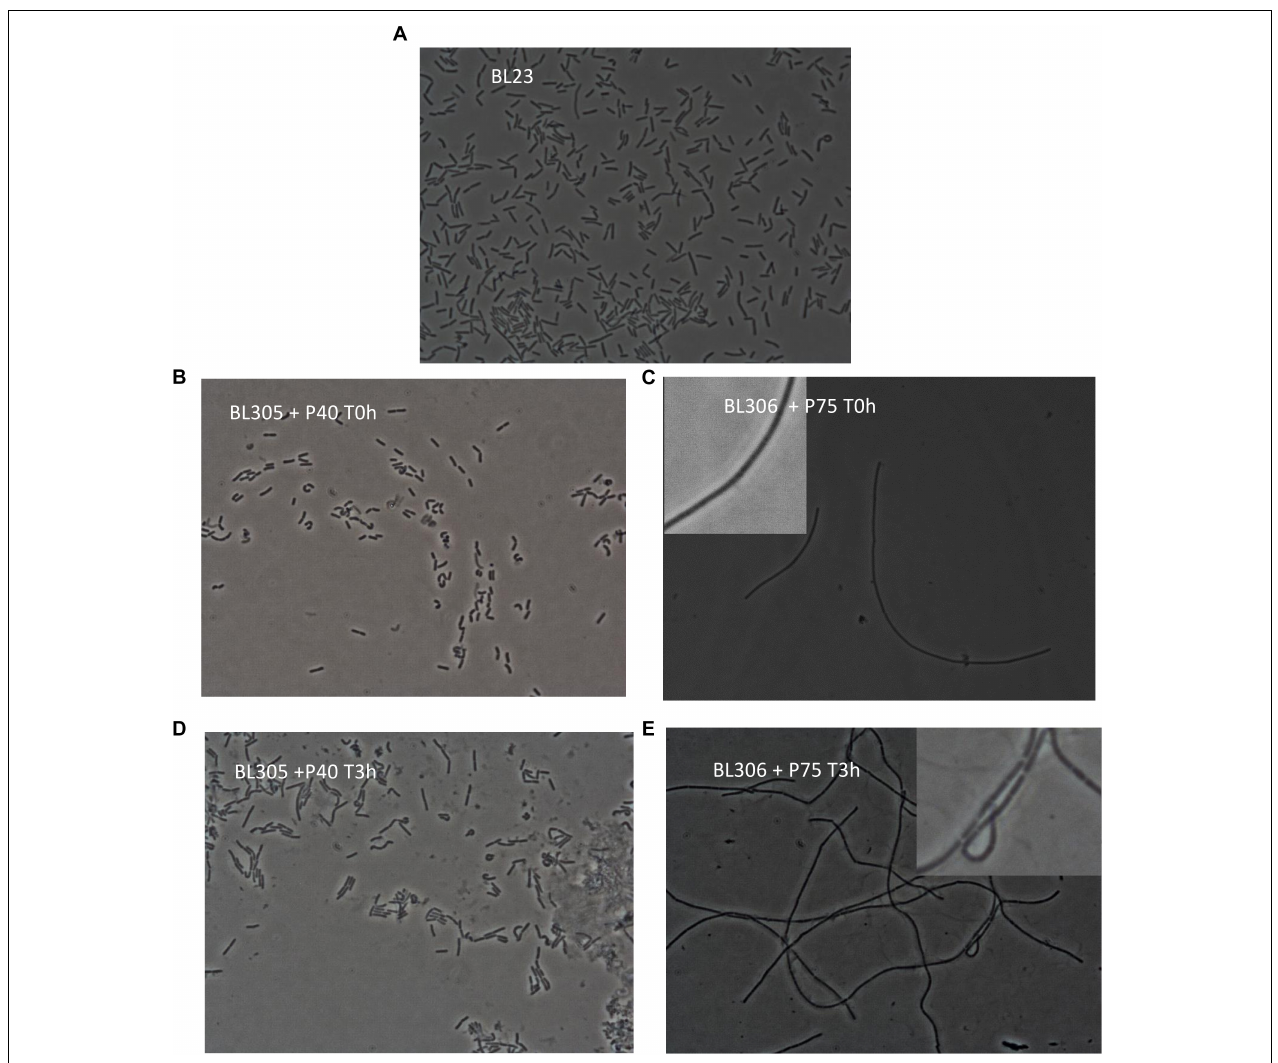
FIGURE 5 | Mutant complementation with purified P40 and P75. Morphological observation by phase contrast transmission microscopy (objective × 100) of L. casei BL23 (A) , L. casei P40 knock down mutant, cmu A (BL305) incubated for 0 h (B) and 3 h (D) with purified P40 (final concentration of 50 µ g/ml), and L. casei P75 knock down mutant, cmu B (BL306) incubated for 0 h (C) and 3 h (E) with purified P75 (final concentration of 50 µ g/ml) and as indicated in the panels. (C,E) Show enlarged details for a better distinction of nascent